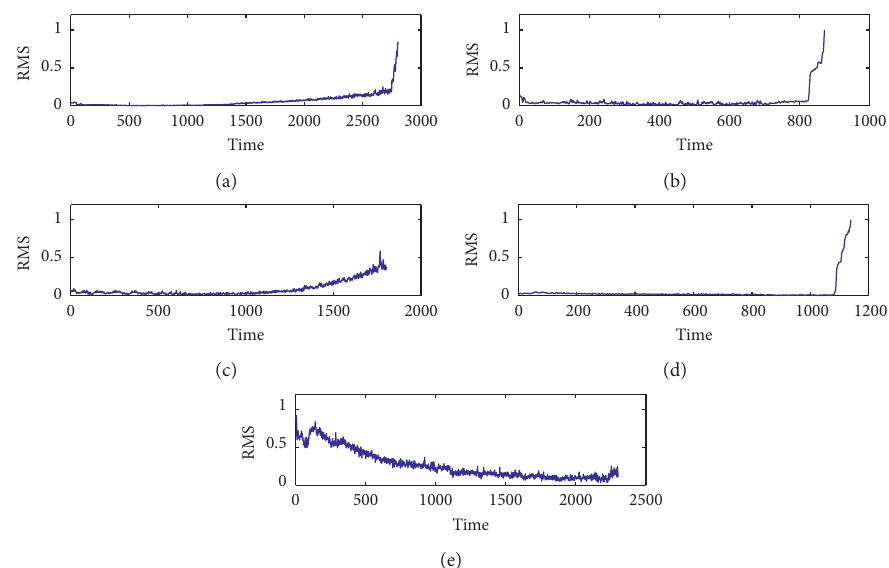
Figure 19: CVs for bearings 11–15 by using RMS under various conditions such as “Normal,” “Slight,” and “Severe.” (a) RMS-bearing 11. (b) RMS-bearing 12. (c) RMS-bearing 13. (d) RMS-bearing 14. (e) RMS-bearing 15.